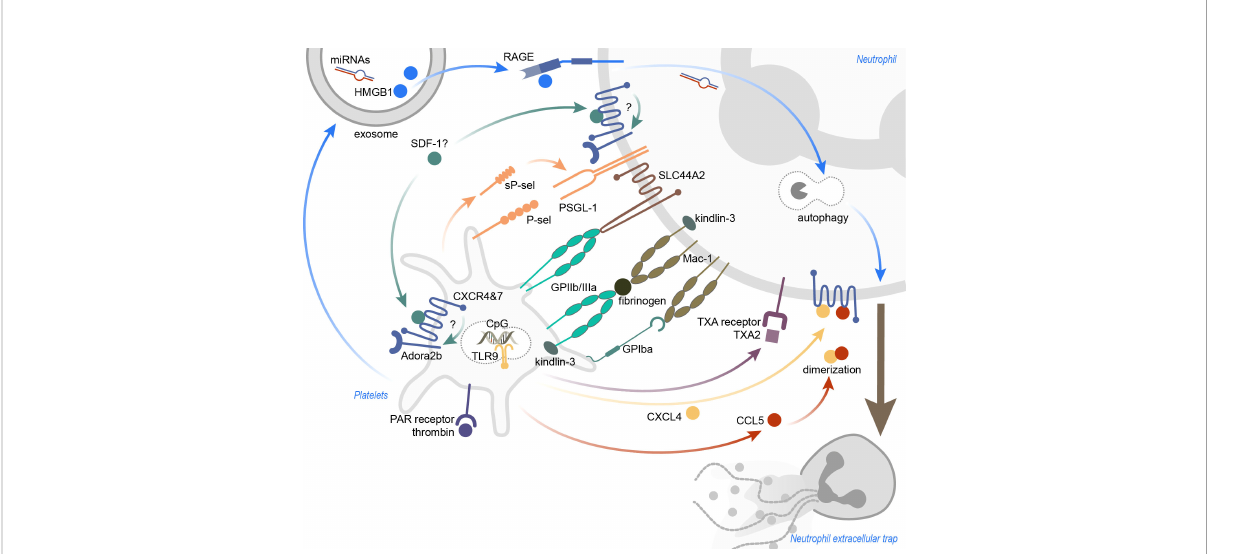
FIGURE 1 In fl ammation-induced platelet-mediated NET formation. The mechanisms leading to platelet-induced NET formation are highly dependent on the surrounding in fl ammatory conditions. Receptor-ligand binding, as well as soluble mediators, were identi fi ed to promote platelet-induced NETosis. Ligation of (soluble) P-sel and neutrophil PSGL-1 was shown to result in NET formation, and also activation of neutrophil Mac-1. SLC44A2 was recently identi fi ed as a mechanotransducer of NETosis. CXCR4 and CXCR7, expressed on platelets and neutrophils, may be important to induce NETosis, and functional Adora2b signaling seems indispensable for this. Thrombin-activated platelets not only recruit neutrophils into the in fl amed tissue, but also stimulate neutrophils to form NETs. Platelet exosomes, carrying HMGB1 and miRNAs, induce NETosis in a RAGE- and autophagy-dependent manner. TLR9 activation via CpG oligonucleotides lead to the discharge of platelet CXCL4, but CXCL4 also heterodimerizes with CCL5 to induce NETs. Lastly, blocking the neutrophil thromboxane receptor diminished NETosis. CXCR, C-X- C motif chemokine receptor; CXCL4, C-X-C motif ligand 4; CCL5, CC-chemokine ligand 5; GP, glycoprotein; HMGB1, high mobility group